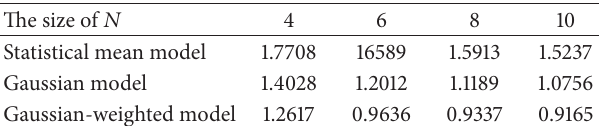
Table 3: Comparison of the positioning error with different beacon nodes.